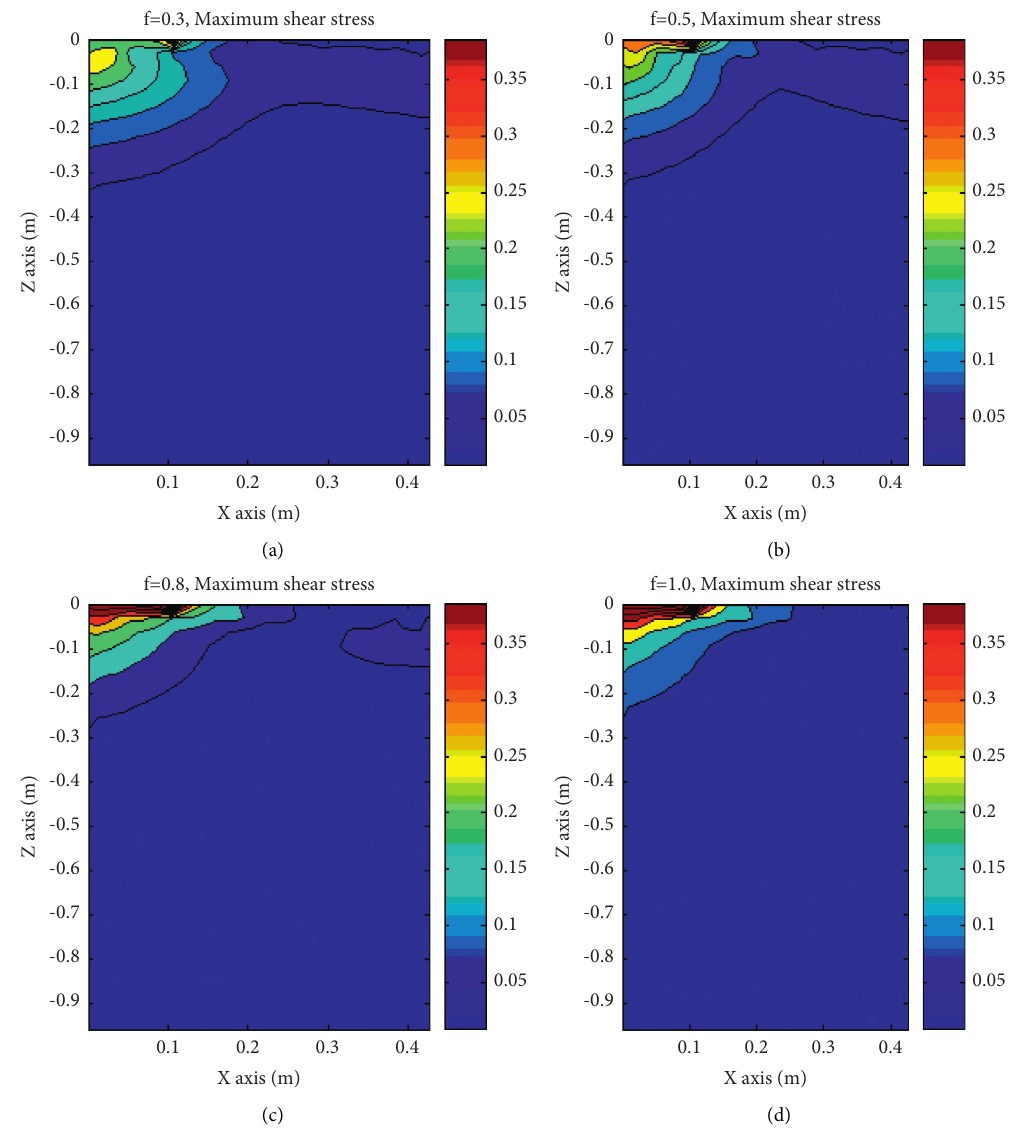
Figure 6: Maximum shear stress nephogram under different friction coefficients. (a) f � 0.3. (b) f � 0.5. (c) f � 0.8. (d) f �